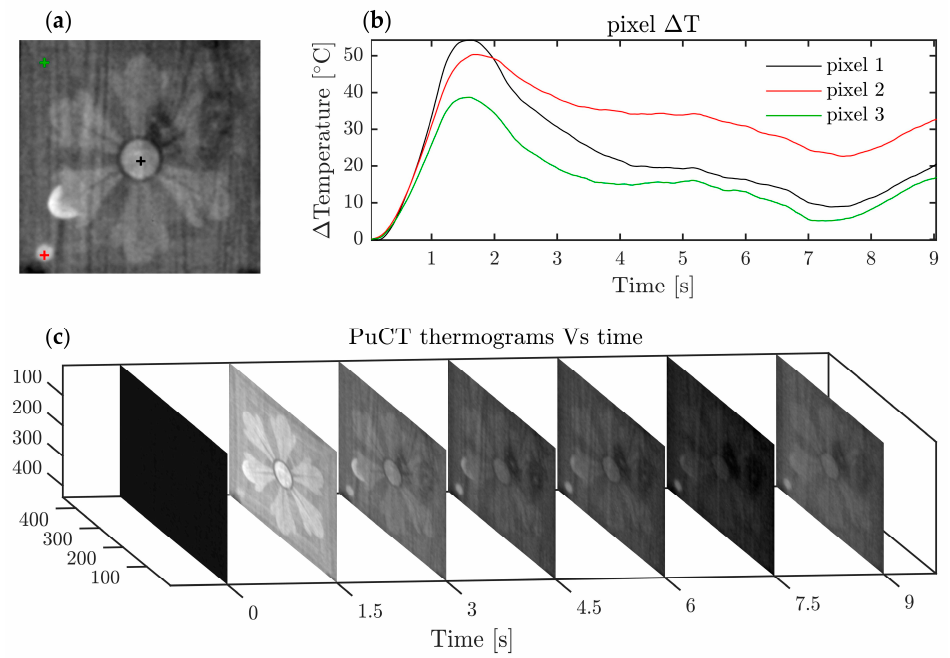
Figure 5. PuCT experimental data collected with FLIR T660, i.e. setup (a) in Fig. 3: ( a ) PuCT image of the SUT with three pixels marked on it; ( b ) marked pixels’ equivalent temperature rise after PuC; ( c ) ( c ) selected thermograms after selected thermograms after PuC.